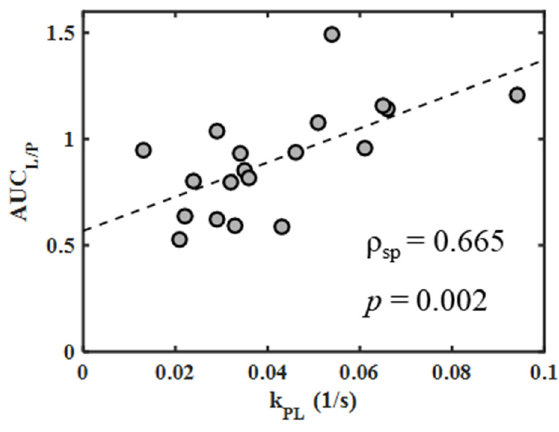
Figure A2. Spearman correlation plot comparing AUC L/P with k PL . The Spearman correlation coefficient ( ρ sp ) and p -value are listed on the plot.